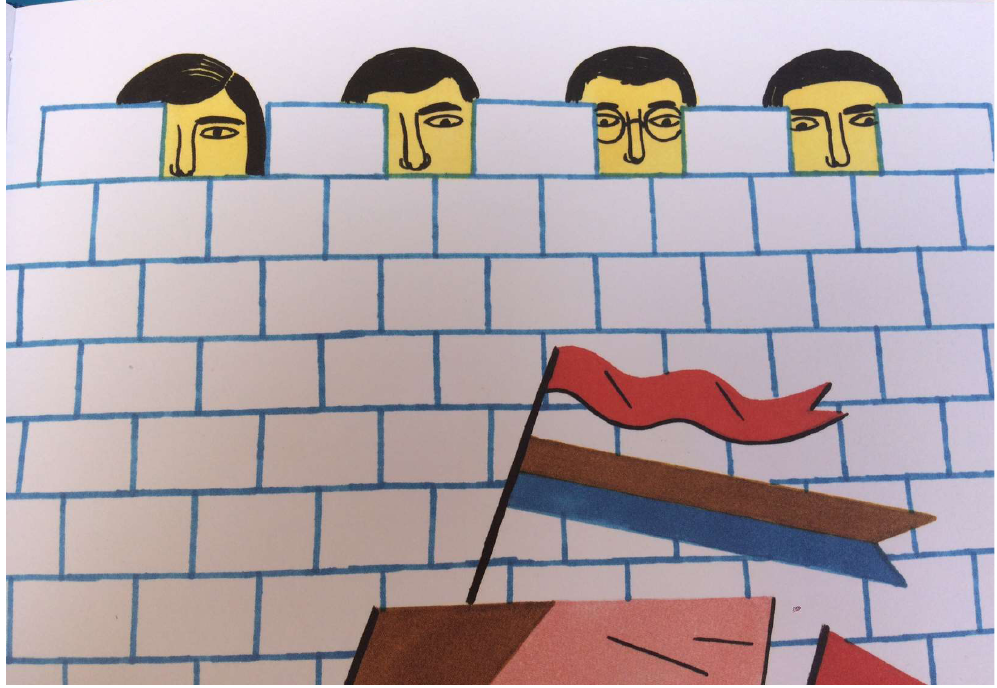
Figure 2. Old or new walls, by: Planète Migrants , cit. p.